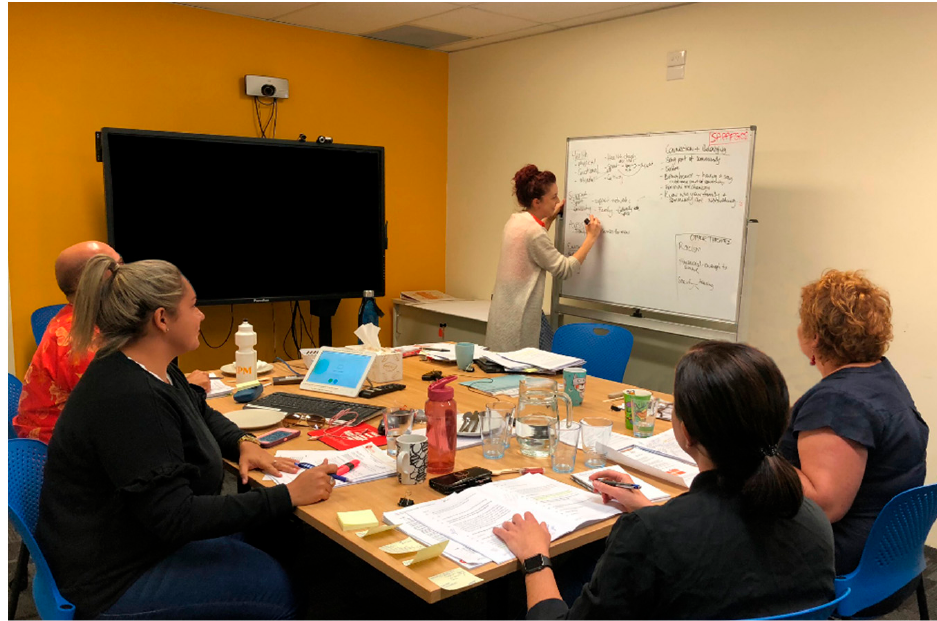
Figure 2 . Meeting of the Indigenous Researchers Group (IRG). Figure 2. Meeting of the Indigenous Researchers Group